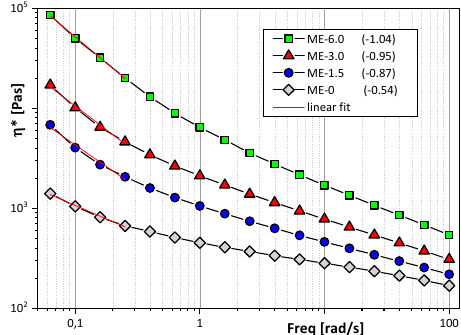
Figure 2. Complex viscosity with di ff erent filler content and shear thinning exponents given in brackets.